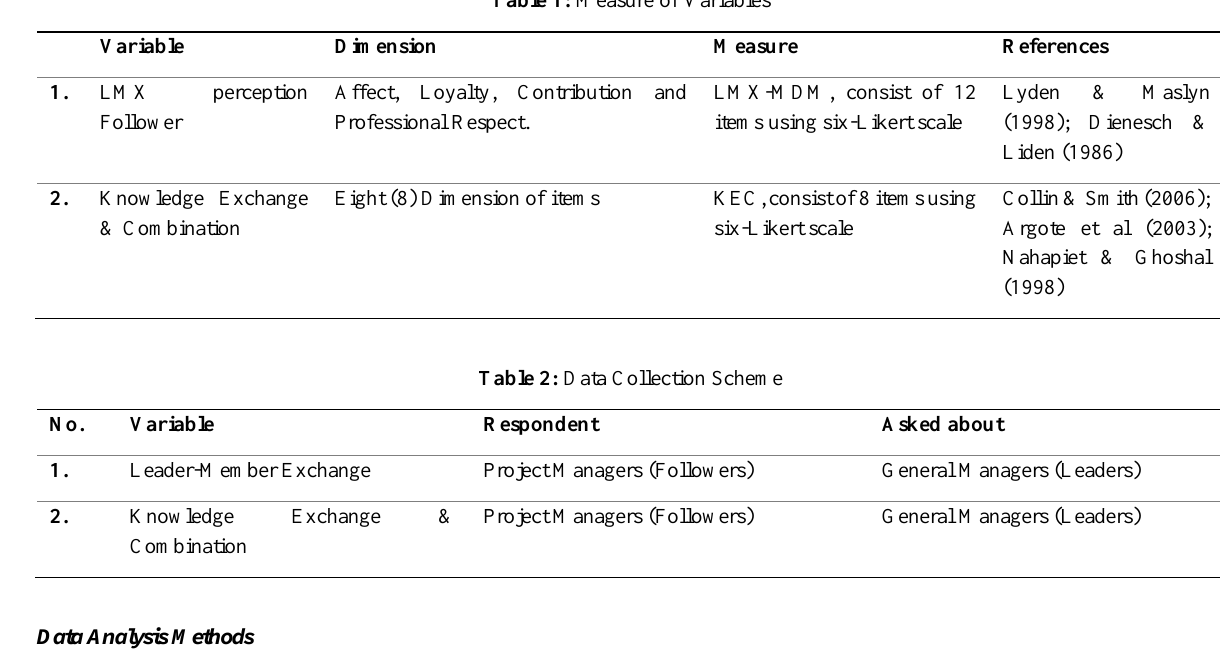
Table 1: Measure of Variables